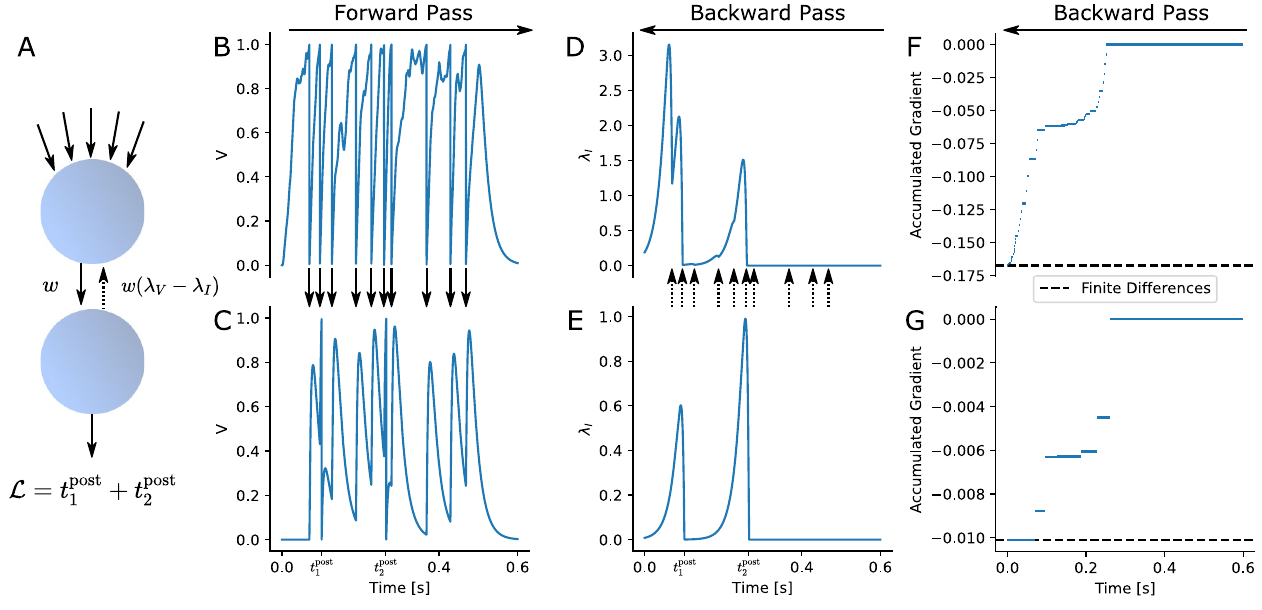
Figure 2. Illustration of EventProp-based gradient calculation in two leaky integrate-and-fire neurons connected with weight w and a spike-time dependent loss L . The forward pass ( B , C ) computes the spike times for both neurons and the backward pass ( D – G ) backpropagates errors at spike times, yielding the gradient as given in Eq. (2). ( A ) The upper neuron receives 100 independent Poisson spike trains with frequency 200 Hz across randomly initialized weights and is connected to the lower neuron via a single weight w . The loss L is a sum of the spike times of the lower neuron. ( B, C ) Membrane potential of upper and lower neuron. Spike times of the upper neuron are indicated using arrows. ( D, E ) Adjoint variable (cid:31) I of upper and lower neuron. The lower neuron backpropagates its error signal (cid:31) V − (cid:31) I at the upper neuron’s spike times (indicated by arrows). ( F, G ) Accumulated gradient for one of the 100 input weights of the upper neuron and the weight w connecting the upper and lower neuron. EventProp computes the adjoint variables from t = T to t = 0 and accumulates the gradients by sampling − τ syn (cid:31) I when spikes are transmitted across the respective weight. The gradients computed in this way match the gradients computed via central differences (dashed lines) up to a relative deviation of less than 10 −